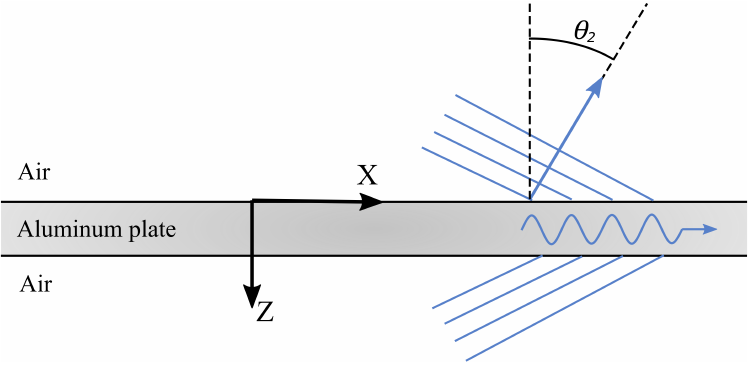
Figure 2. Schematic of the plate waveguide being